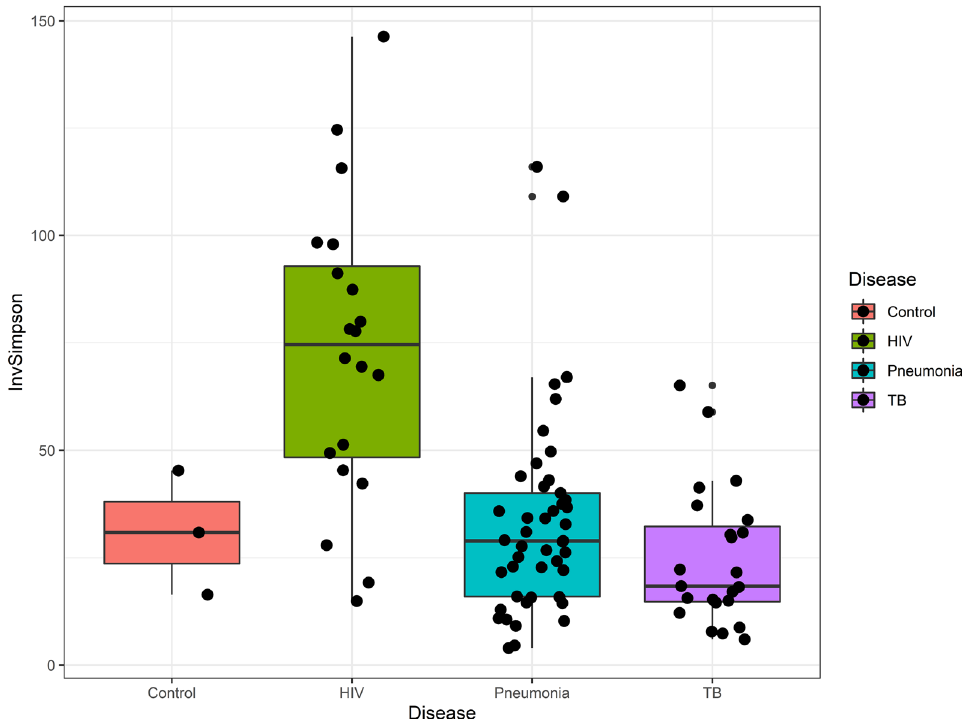
Figure 4. Box plot of the Inverse Simpson alpha diversity between cohorts the HIV (green), Pneumonia (blue) and TB (purple). The negative controls (red) were 0.9% saline samples.